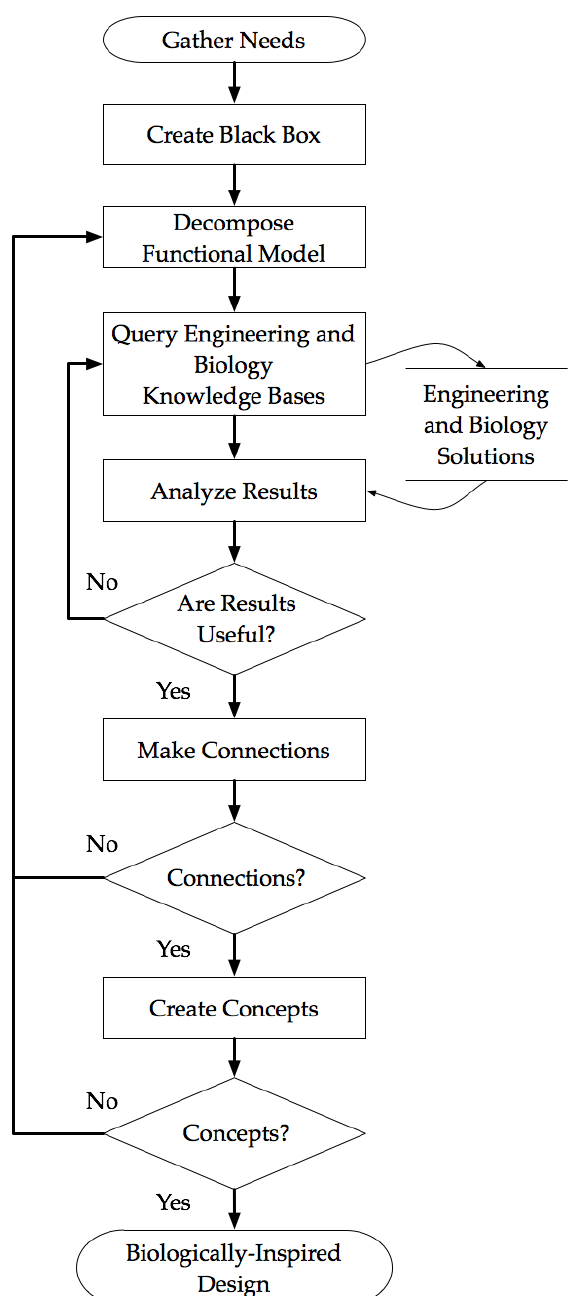
Figure 1. Flow chart of biologically-inspired design